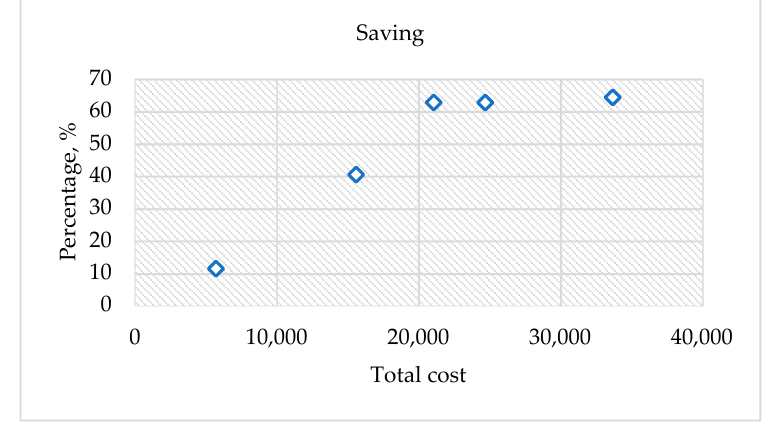
Figure 20. Percentage cost to be saved.